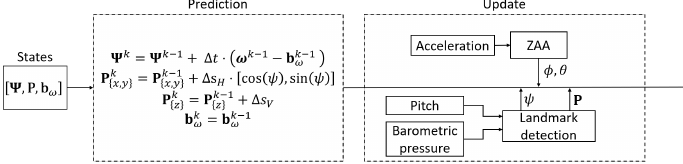
Figure 18. Architecture of the UKF used for orientation